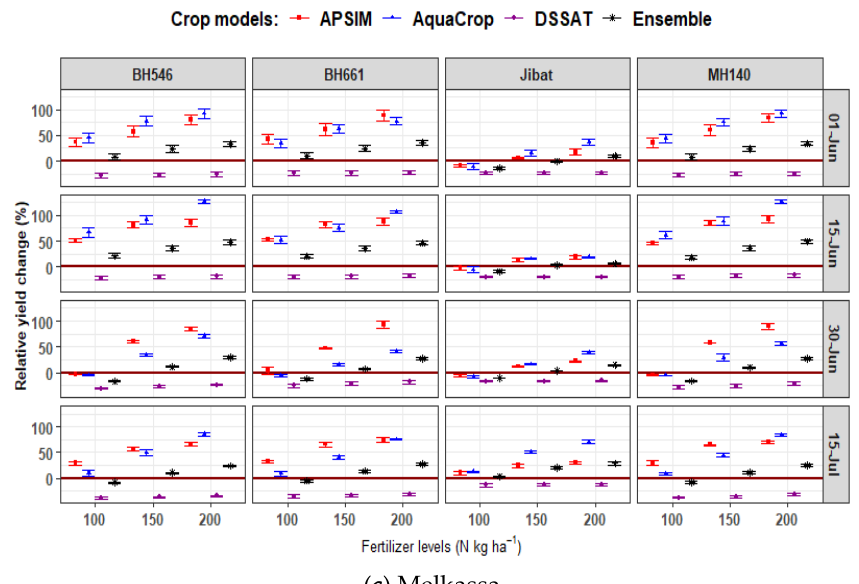
Figure 5. Percentage yield change in 2030 relative to the baseline control treatments as simulated with APSIM, AquaCrop, and DSSAT crop models for ( a ) Ambo (high altitude), ( b ) Bako (mid-altitude), and ( c ) Melkassa (low altitude). Error bars show the standard deviation of the change of maize yield simulated for multiple GCM projections.